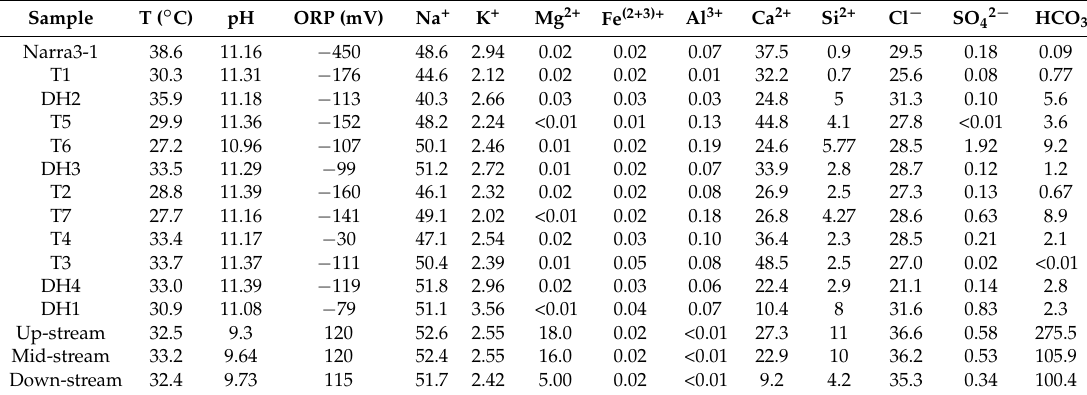
Table 1. On-site measurements and concentrations of major cations and anions in